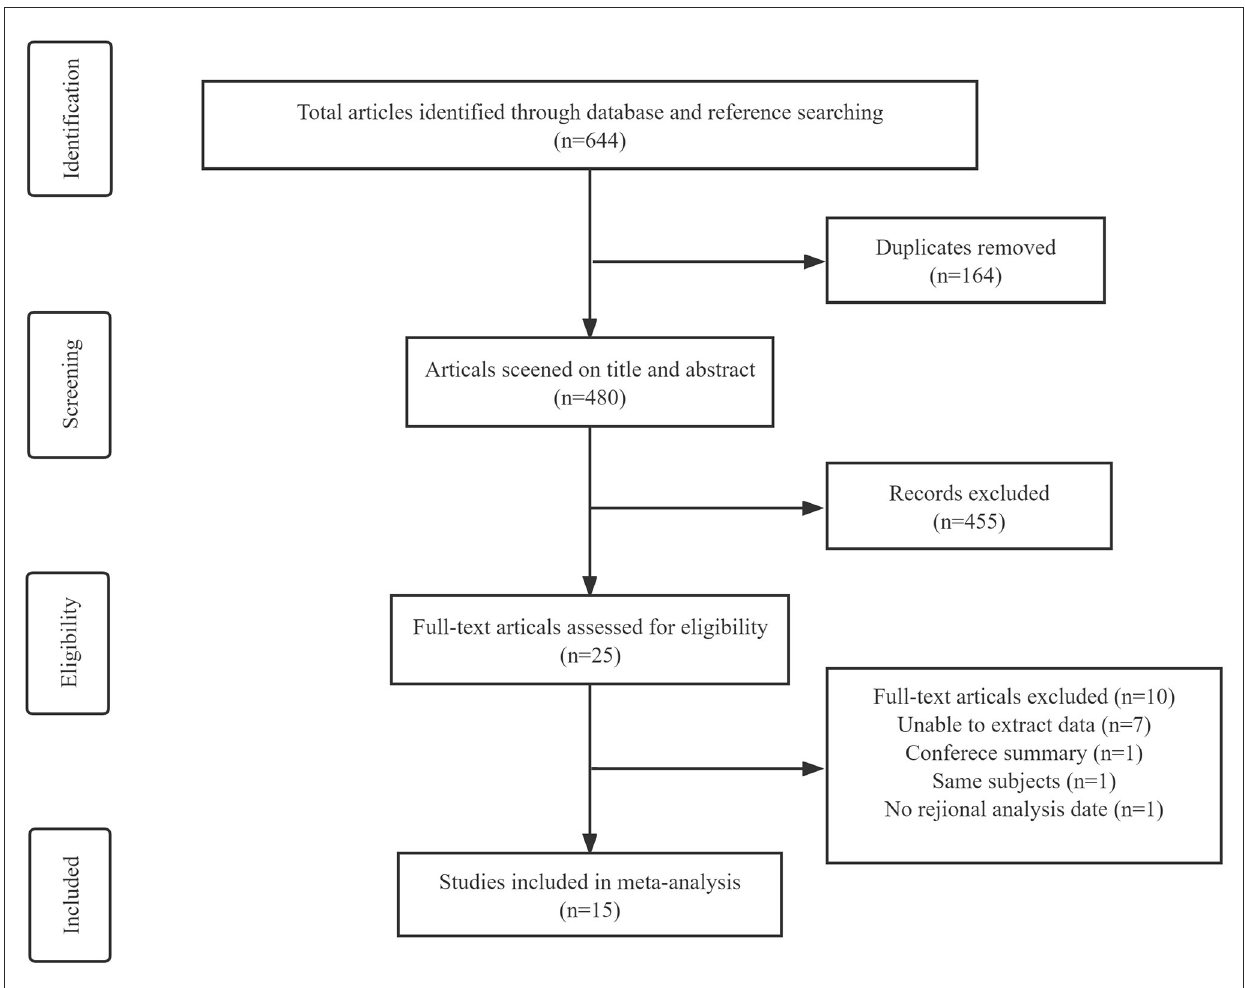
FIGURE1 Flow diagram of the study selection